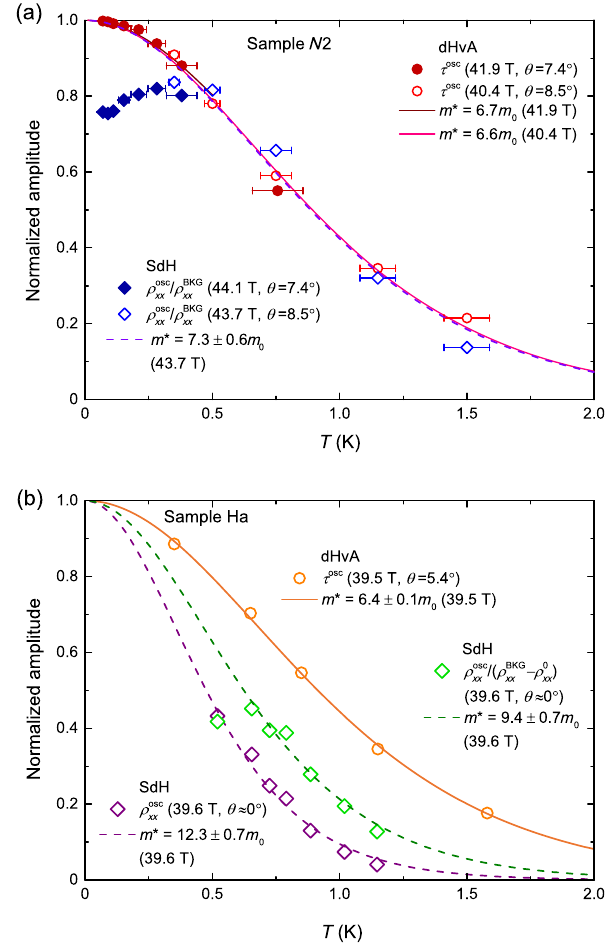
FIG. 7. Normalized quantum-oscillation amplitudes versus temperature for (a) sample N 2 and (b) sample Ha. The dHvA amplitude τ osc is obtained by subtracting a polynomial back- ground from the magnetic torque τ ð H Þ [35]. For sample N 2 , the = ρ BKG , i.e., the oscillatory part of SdH amplitude is taken as ρ osc xx xx resistivity ρ osc divided by the nonoscillatory background at the xx corresponding magnetic field. For sample Ha, a T -independent component ρ 0 is further removed from the nonoscillatory xx (see text). The absolute ρ osc without resistivity background ρ BKG xx xx normalization using the background resistivity (purple diamonds) is also shown for comparison. Solid and dashed lines are fits to the LK formula for dHvA and SdH amplitudes, respectively. The inferred effective masses are shown beside the fits. Note that all the nonmonotonic T dependence of the SdH amplitudes are caused by the normalization; see the raw data presented in Supplemental Material Fig. 1(c)